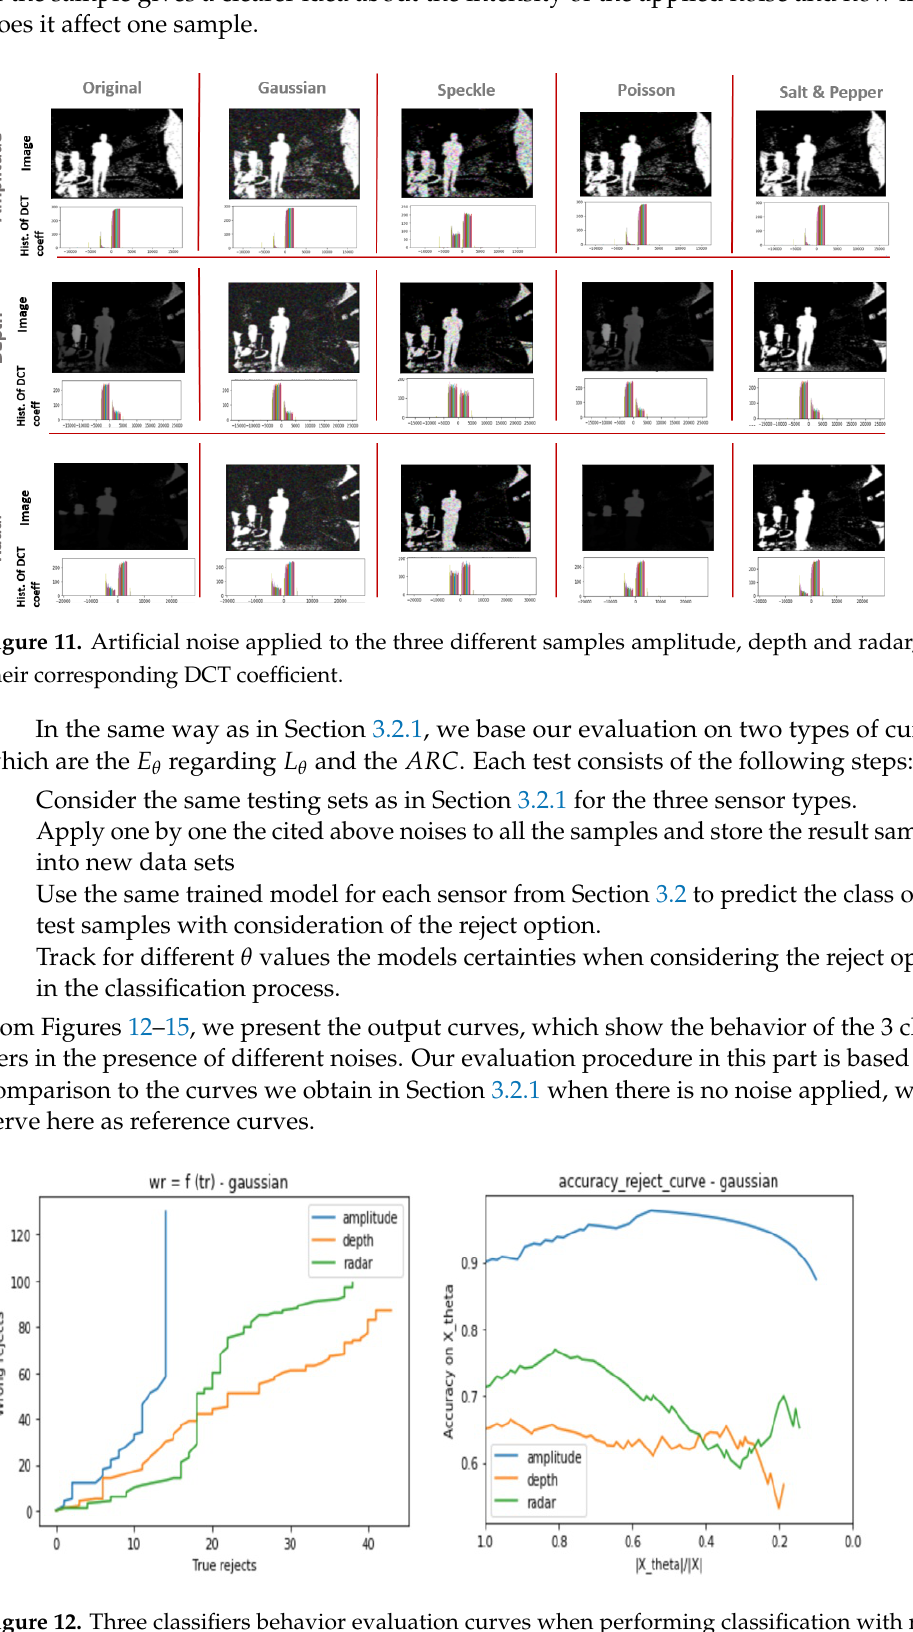
Figure 12. Three classifiers behavior evaluation curves when performing classification with reject option on noisy data sets—considering Gaussian